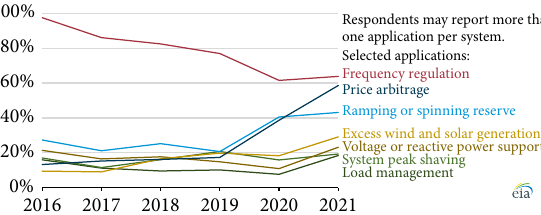
Fig. 1 Application of utility-scale battery storage capacity in United States 2016−2021 [7]